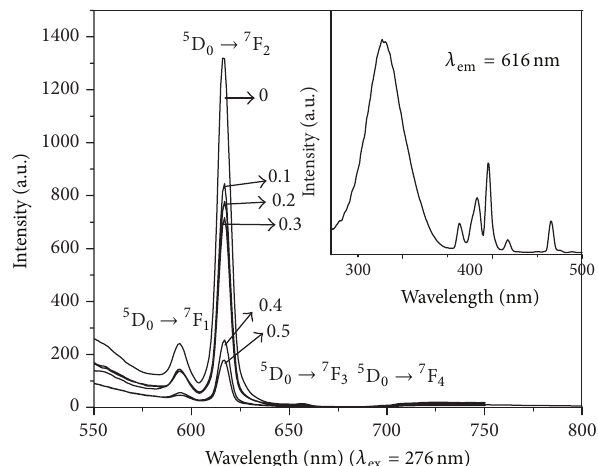
Figure5:Emissionspectraof(Ca 1−𝑥 ,Gd 𝑥 )MoO 4 :0.05Eu 3+ ( 𝑥 = 0.1 , 0.2, 0.3, 0.4, and 0.5) phosphors ( 𝜆 spectrum of (Ca 0.1 , Gd 0.9 )MoO 4 :Eu 3+ (5mol%) phosphors ( 𝜆 615 nm,